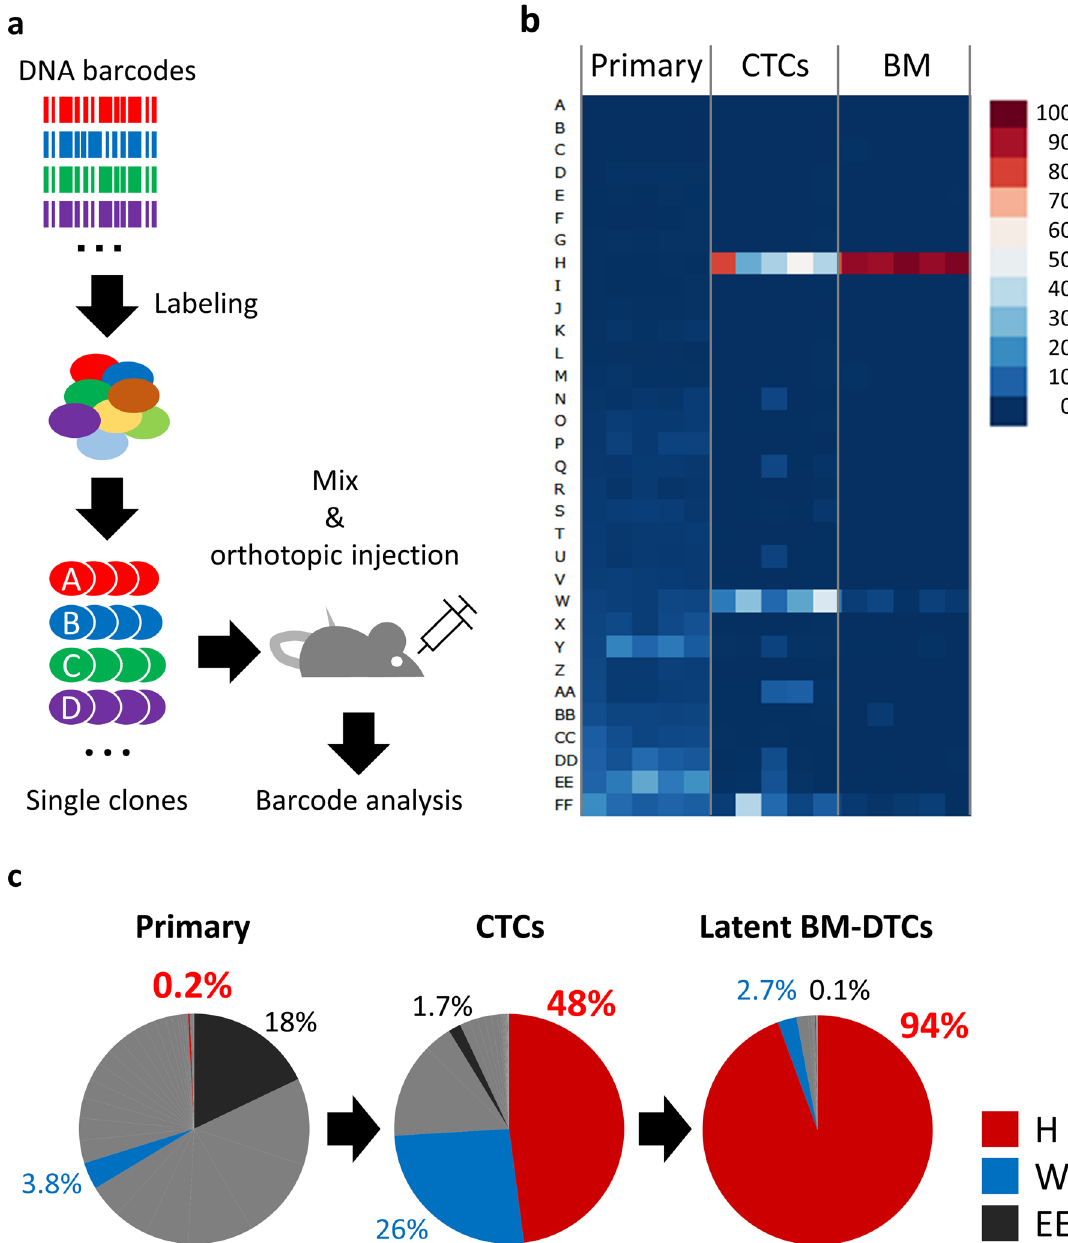
Figure 3. Identification of a clone dominating CTCs and DTCs. ( a ) Strategy for isolating individual SAS-GL clones with molecular barcodes. ( b ) Relative proportions of clonal lines among primary tumors, CTCs, and BM in mice ( n = 5). ( c ) Pie charts showing abundance of clone H (red), clone W (blue), and clone EE (black) in primary tumors, CTCs, and latent BM-DTCs in mice. The mean percentage of each clone is given for each CTCs (Fig. 2b,c, right panel). The highly reproducible behavior of each clone indicated that clonal dominance observed in CTCs and DTCs was attributed to the distinct intrinsic properties of each clone. Identification of an origin clone dominating CTCs and DTCs.